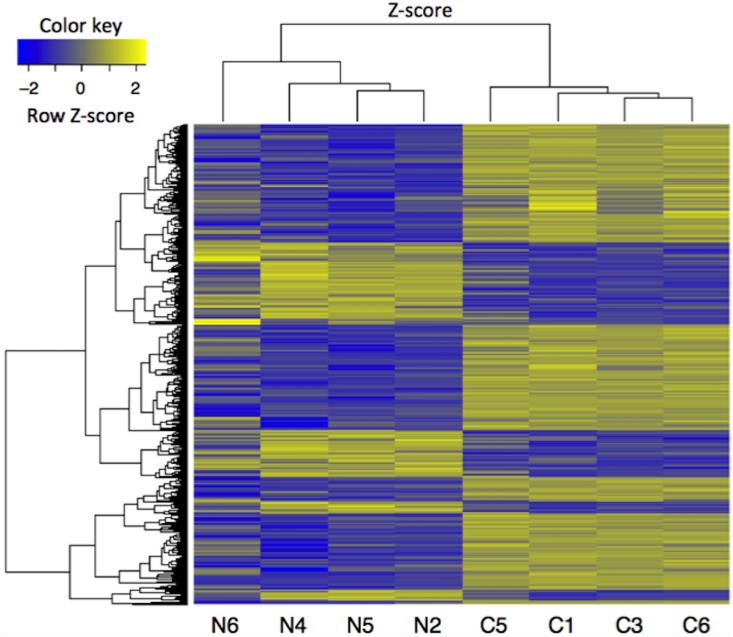
Hierarchical cluster analysis of differentially expressed genes (|fold change| ≥ 2 and adjusted P-value < 0.05) in bronchial smooth muscle tissues of the antigen-challenged mice. Total RNA sample of each mouse (4 animals, respectively) was subjected to the microarray analysis, and hierarchical cluster analysis of differentially expressed genes was performed. Each row represents a differentially expressed gene and each column represents an individual mouse. N and C represent the normal control and the repeatedly antigen-challenged groups, respectively. Each group contains four different animals. Colors represent fold change in each individual, with yellow indicating up-regulated genes and blue indicating down-regulated genes with respect to the average of the normal control animals.